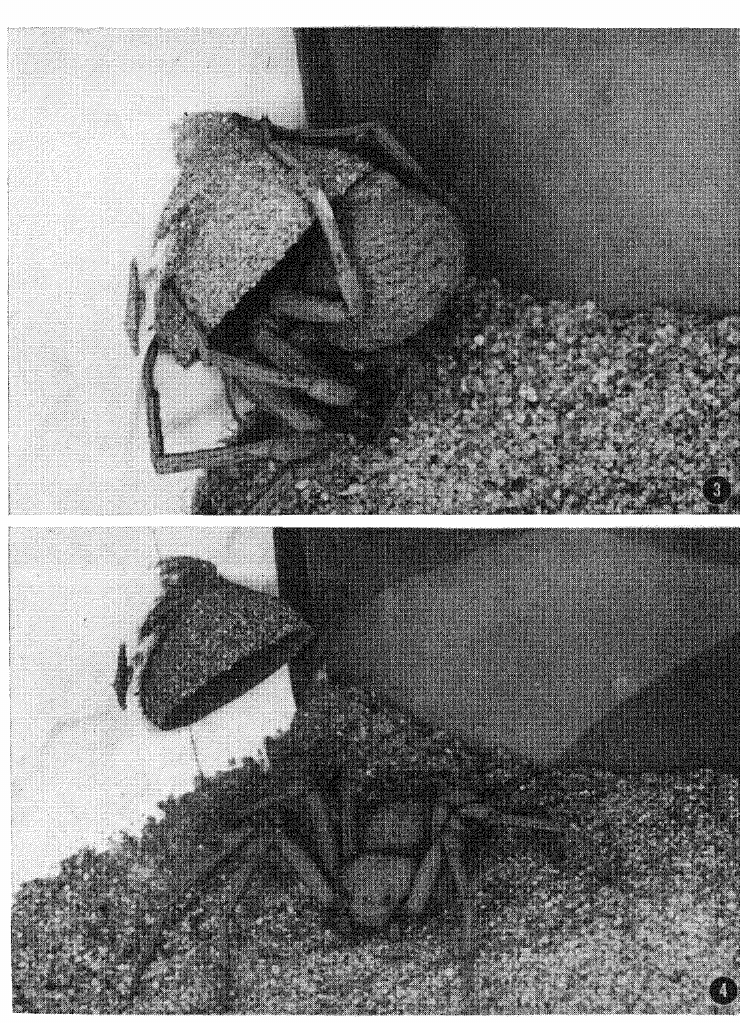
Fig. 3. Female Sicarius incorporating fine sand particles, held in a disc around spinnerets, into the eggcase wall with silk. Notice the difference in grain size of the substrate and the material picked up. Photograph taken minutes after Fig. 2. Fig. 4. Eggcase ready to receive the eggs. The rim is now circular and smooth. Photograph taken 14 June at 21